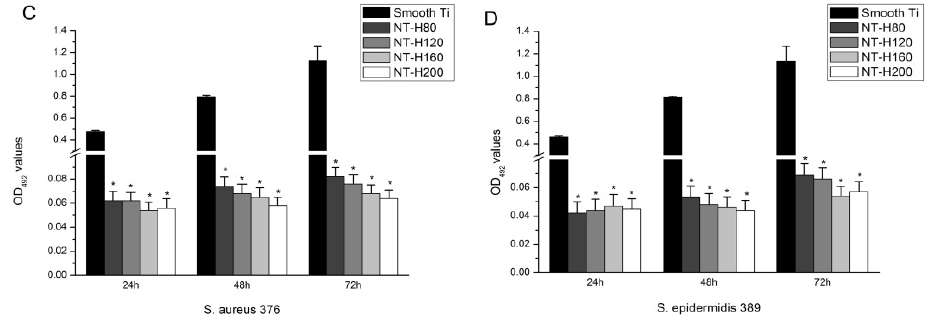
Figure 4. Biofilm formation of the three bacterial strains. ( A ) ATCC 43300; ( B ) ATCC 35984; ( C ) Staphylococcus aureus 376; and ( D ) S. epidermidis 389 on Smooth Ti and NT ‐ H surfaces at 24 h, 48 h, and 72 h, as detected by the tissue culture plate method. * denotes a significant difference compared to Smooth Ti ( P < 0.01). # denotes a significant difference compared to NT ‐ H80 and NT ‐ H120 ( P < 0.01).